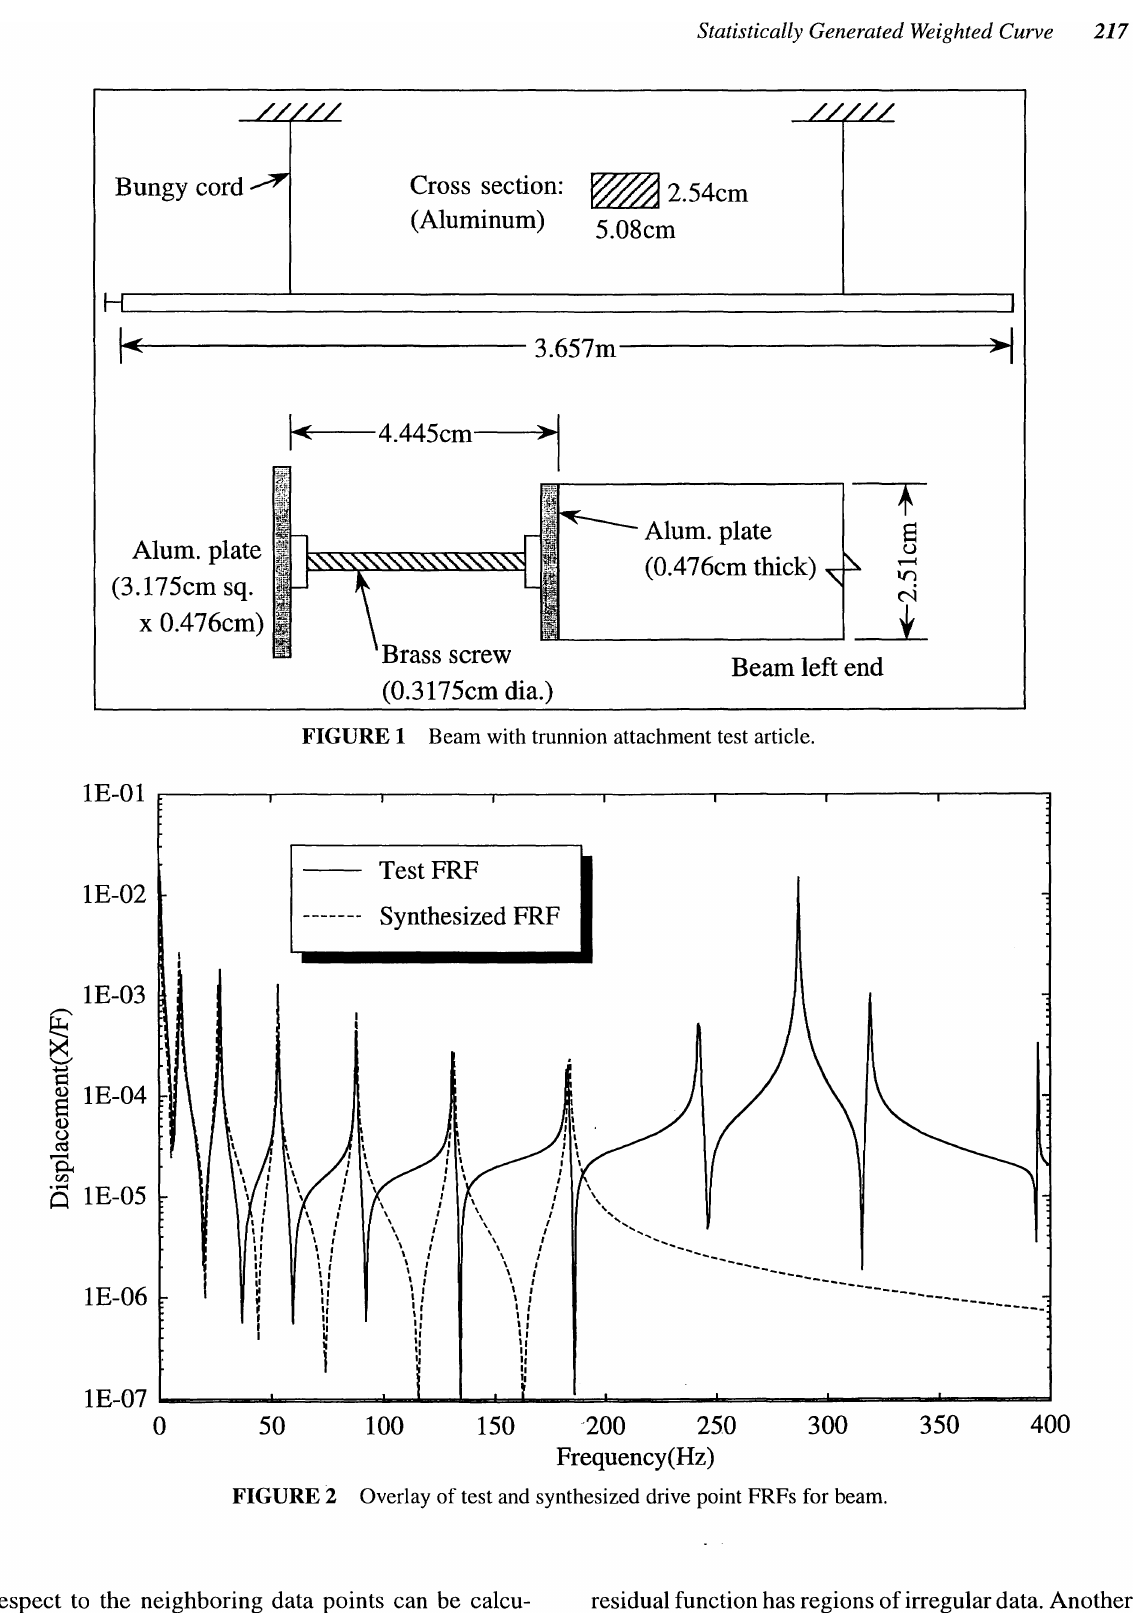
residual function has regions of irregular data. Another curve fit was performed using the statistically gener ated weighting function [Eq. (30)] and the results were highly accurate (Fig.